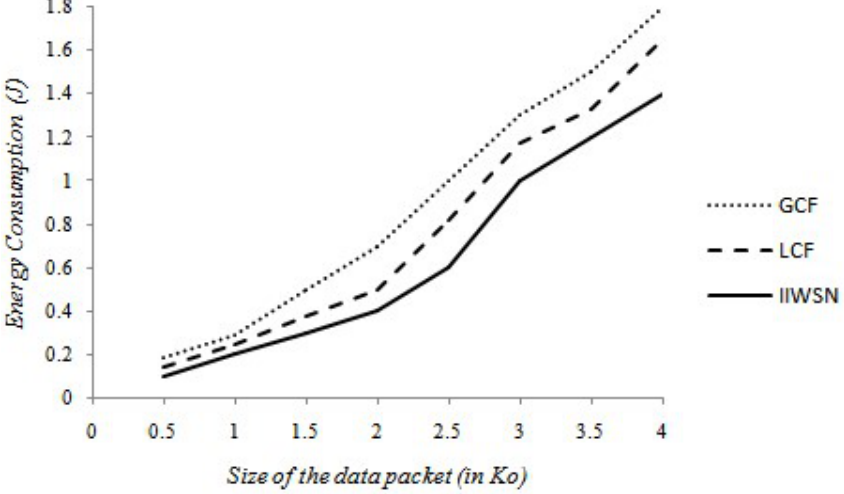
Figure 9. Energy consumption based on network size.